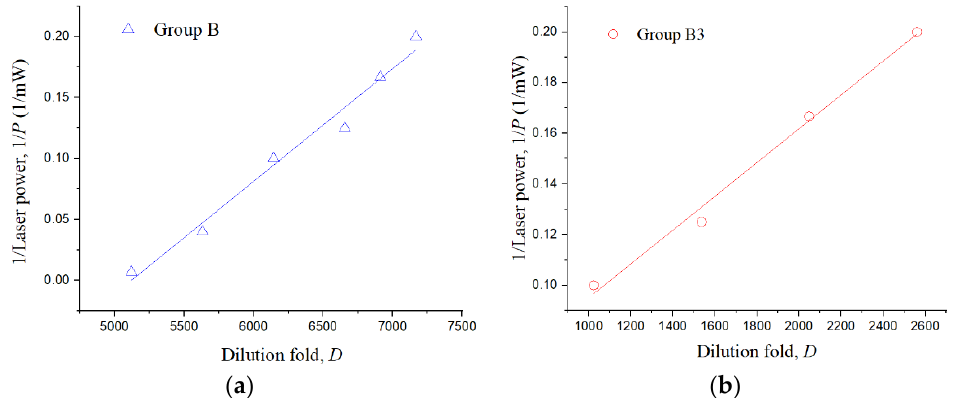
Figure 4. The relationship between fold dilutions ( D ) and laser powers ( P ). ( a , b ) are group B and group B3 cells, respectively.